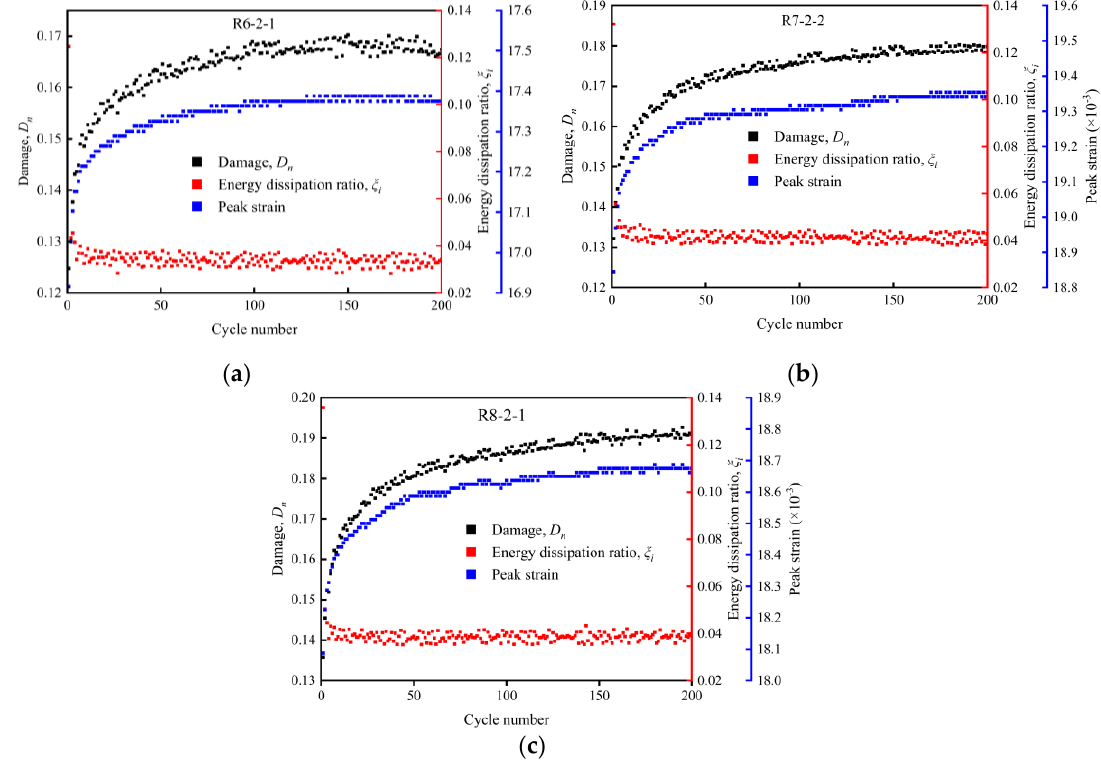
Figure 12. The relationship of the rock specimen damage variable, energy dissipation ratio of a single cycle, peak strain, and cyclic number under three different kinds of stress upper limits in the cyclic loading and unloading test: ( a ) 60%, ( b ) 70%, and ( c ) 80% of σ c .